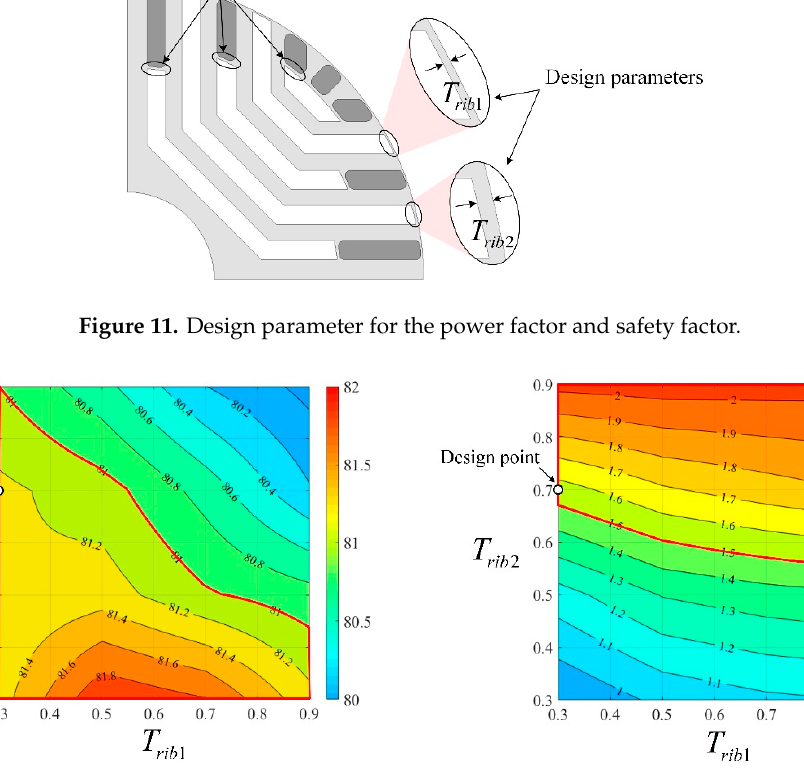
Figure 13. Final model of LS-SynRM.